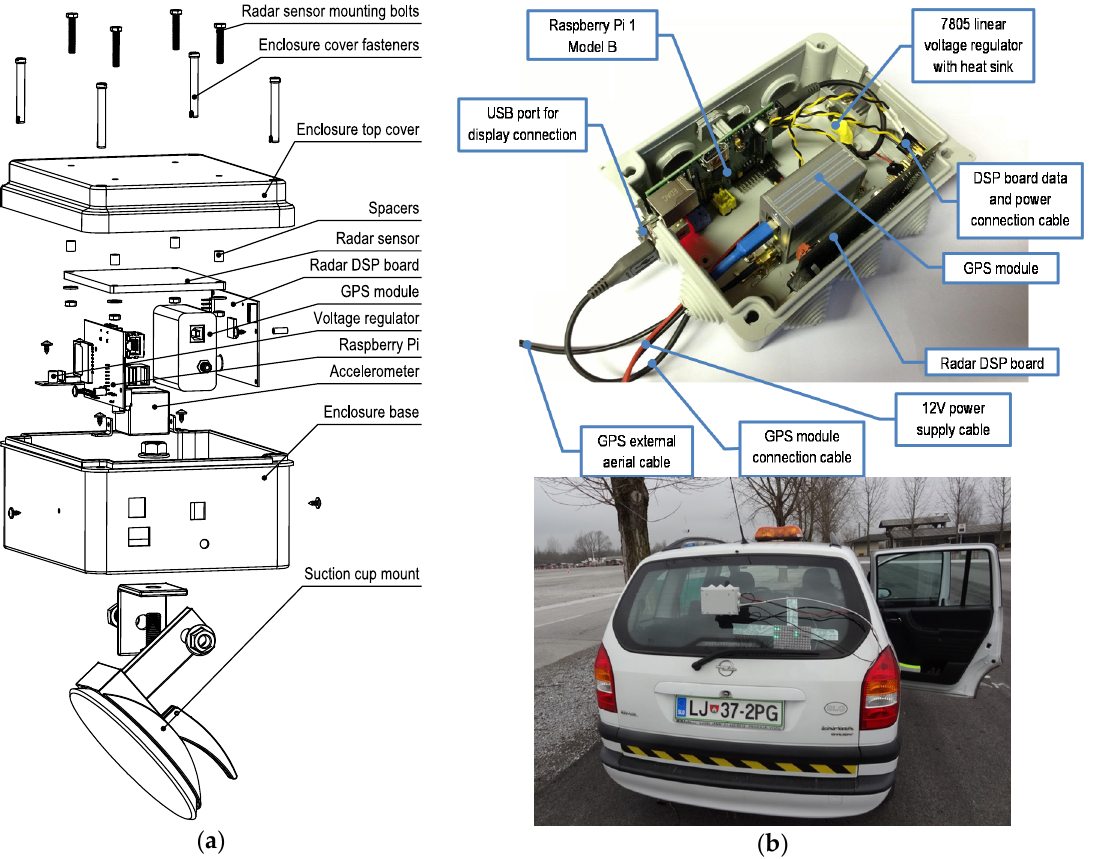
Figure 3. Components mounted in the enclosure. ( a ) Explosion drawing of the assembly model used for component layout design; ( b ) actual assembly and mounting on a vehicle.